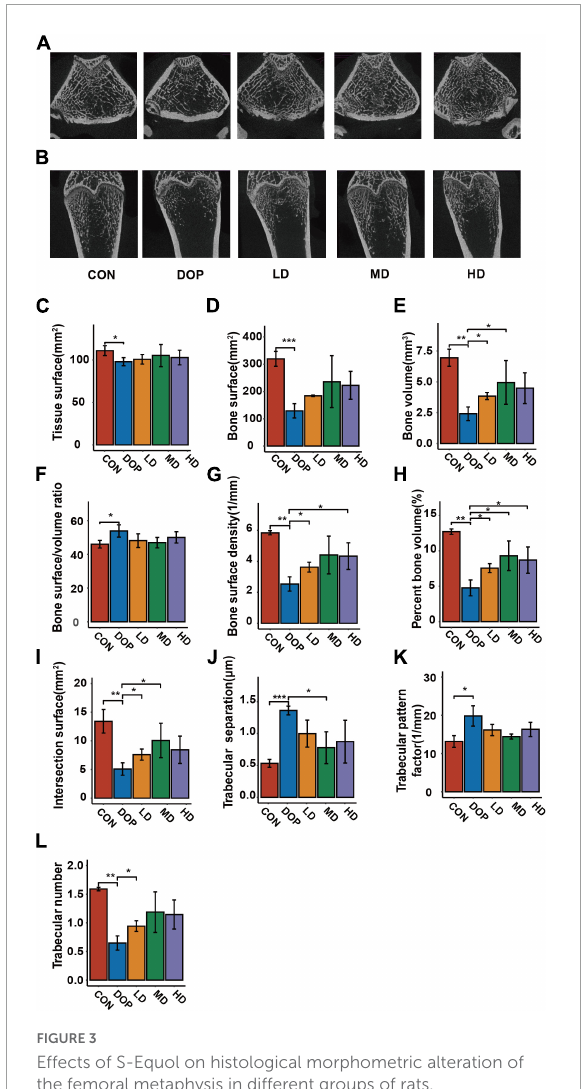
FIGURE3 Effects of S-Equol on histological morphometric alteration of the femoral metaphysis in different groups of rats. (A) Representative microcomputed tomography coronal section images of femoral trabecular bone micro-architecture; (B) representative microcomputed tomography coronal section images of femoral trabecular bone micro-architecture; (C) tissue surface; (D) bone surface; (E) bone volume; (F) bone surface/volume ratio; (G) bone surface density; (H) percent bone volume; (I) intersection surface; (J) trabecular number; (K) trabecular separation ratio; (L) intersection surface. All data are expressed as mean ± SD ( n = 3). * p < 0.05, ** p < 0.01, *** p < 0.001 as compared to the diabetic osteoporosis (DOP)